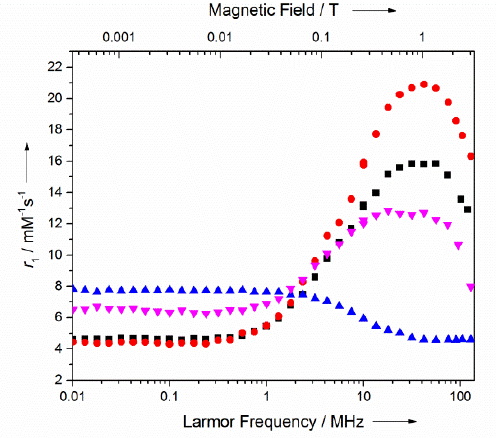
Figure 2. The nuclear magnetic relaxation dispersion (NMRD) profiles of Gd-DTPA ( ), MnTPPS ( ), m -MnP2 ( ), and MnP2( ) in 25 mM pH 7.2 HEPES buffer from 0.23 mT to 3 T at 25 °C. MnP r 1 was normalized to per Mn(III) ion.